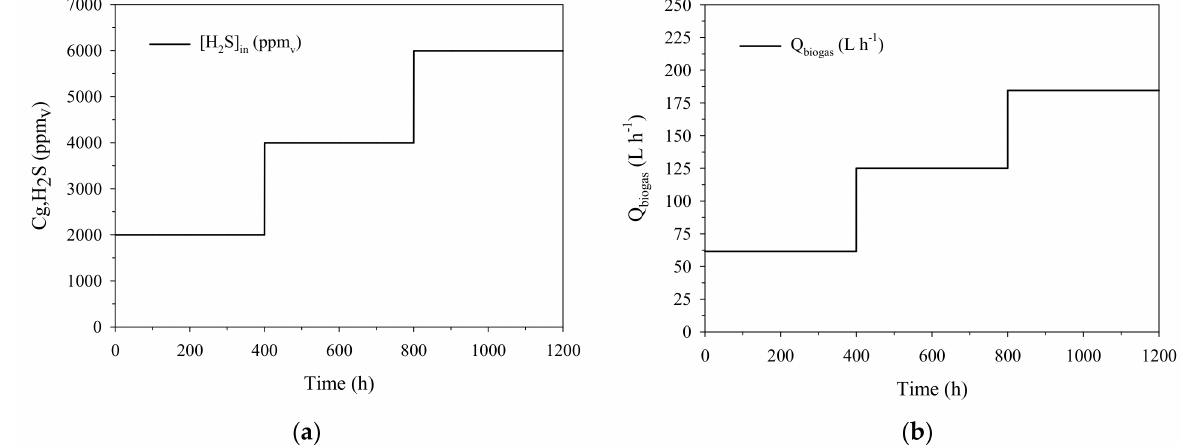
Figure 2. Inlet profile to simulate ( a ) H 2 S inlet concentration changes and ( b ) biogas flow rate